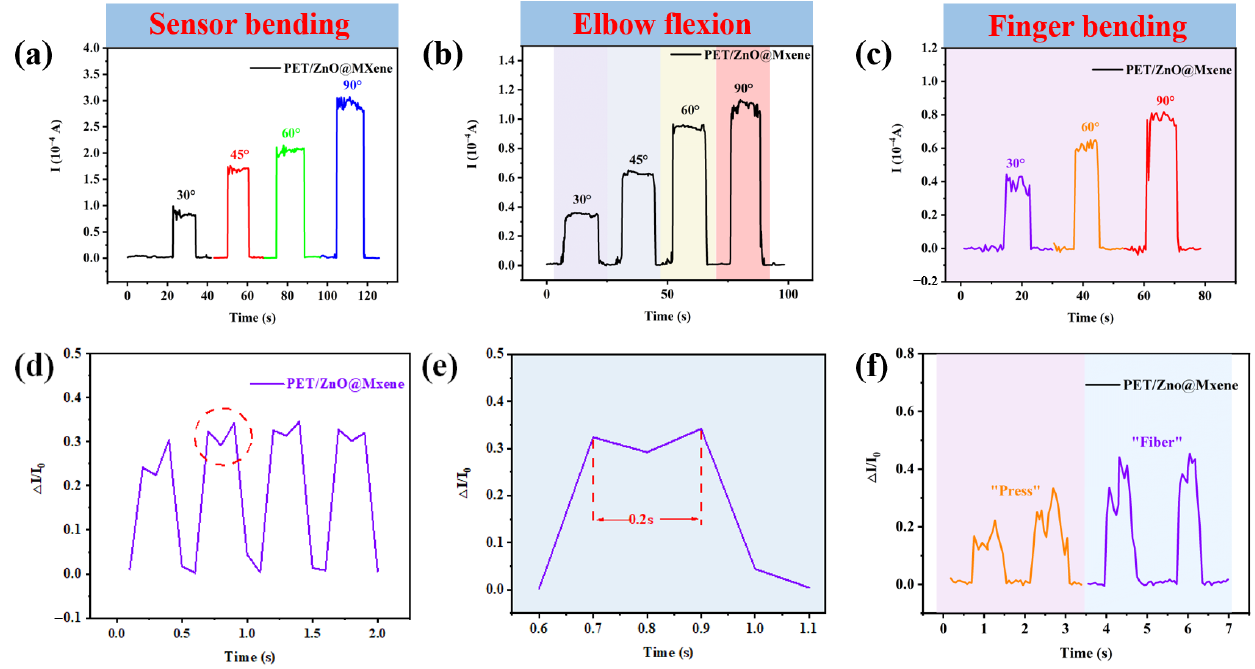
Figure 5. Current response curve ( a ) when pure device is bent, ( b ) when elbow joint is bent, ( c ) when finger is bent, ( d ) of pulse vibration. ( e ) pulse amplification curve of a single period, and ( f ) vocal cord vibration